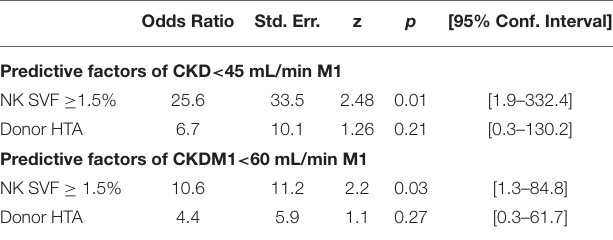
TABLE 4 | Logistic regression models linking the presence of PRAT-SVF NK cell infiltrates to lowered allograft function evaluated 1-month (M1)